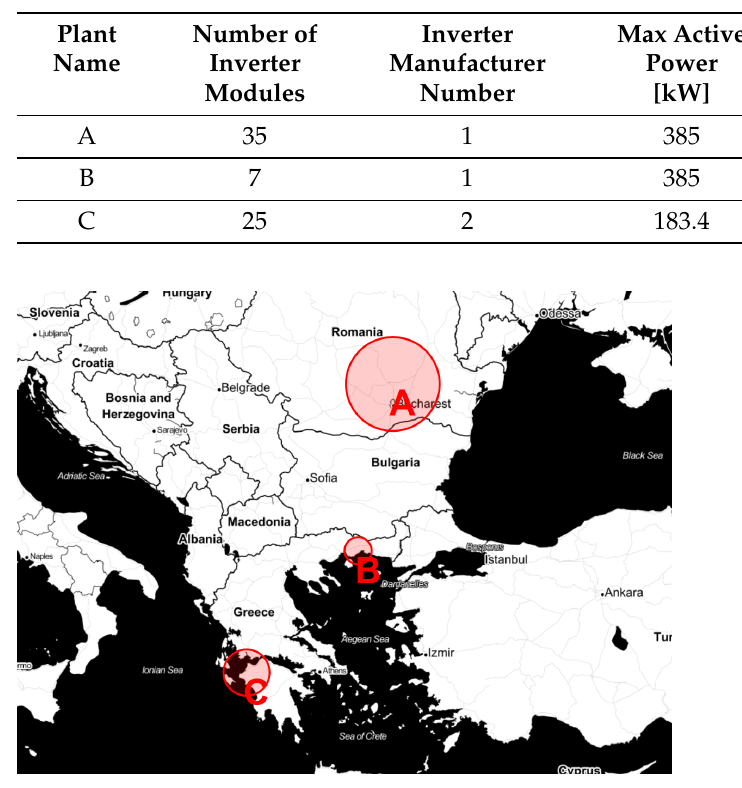
Figure 1. Location of the three considered PV plants, which are denoted as A, B, C. The marker size is proportional to the installed capacity, which is shown in Table